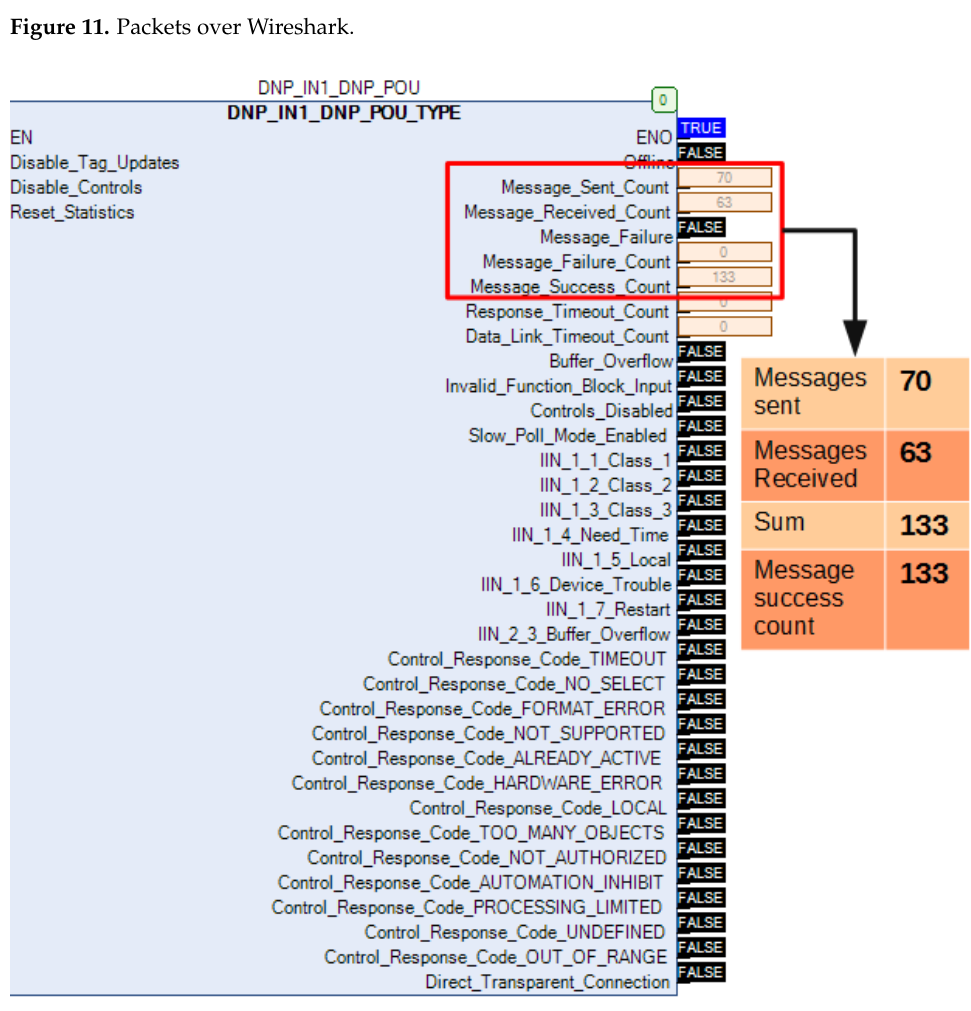
Figure 12. Data communicated over DNP3 on